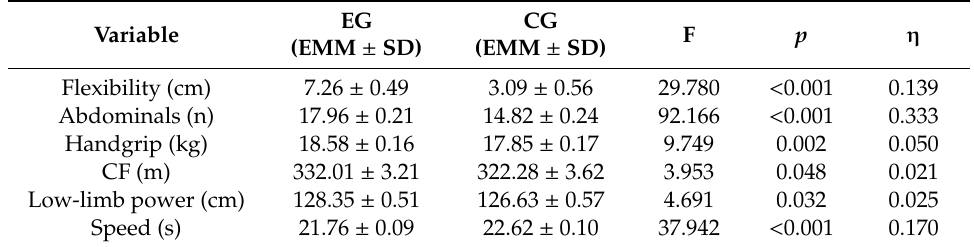
Table 4. Results of the univariate analysis of covariance for the analysis of inter-group di ff erences at post-test. Variable